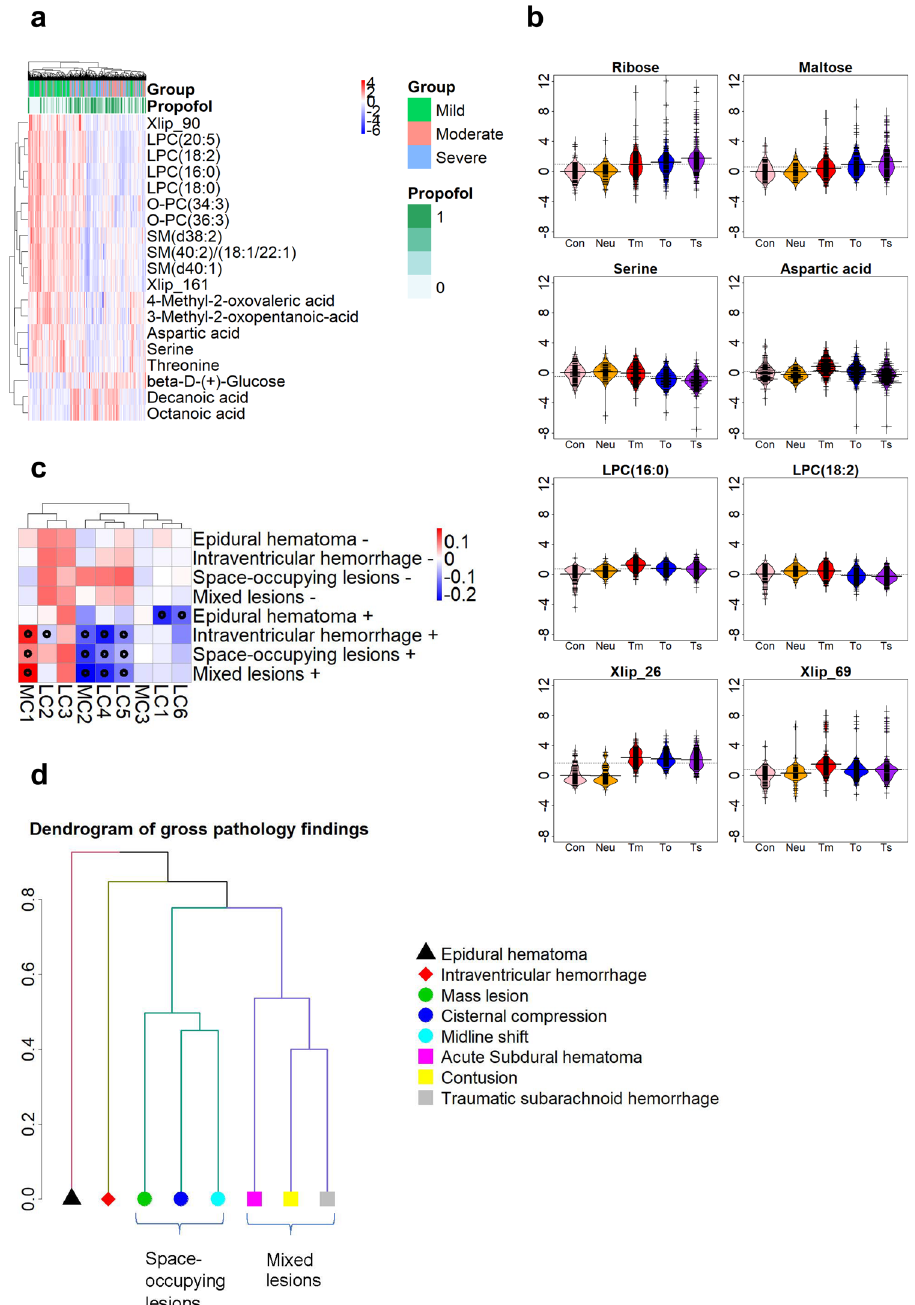
Fig. 3 Survey of metabolome in TBI severity and gross pathologies. a Heatmap of the 19 most important features for discrimination of TBI severity, showing also study group and propofol administration. These features were selected from the overall of the top 30 metabolites from a random forest model and the top 30 metabolites as selected by the Welch F test. b Levels of selected top-ranking metabolites across six study groups. The data were standardized based on the levels of internal medicine and orthopedic patients, denoted as controls. Group abbreviations: Con (control; internal and orthopedic), Neuro (neurological patients, mostly acute stroke), Tm (mild TBI), To (moderate TBI), Ts (severe TBI). c Heatmap of the gross pathologies fi ndings and the 11 metabolite clusters. Boxes with stars denote signi fi cant differences between positive and negative fi ndings. d Dendrogram of the clustering results for the gross pathology types from CT. A hierarchical clustering method was applied where a similarity measure between the common combinations was used as the metric for the clustering. The y-axis in the plot denotes the dissimilarity measure based on the Jaccard distance of the difference pathologies, with distance close to 0 being the most similar. Based on these, mass lesion, cisternal compression, and midline shift were grouped in the space-occupying cluster, and acute subdural hematoma, contusion, and traumatic subarachnoid hemorrhage were grouped as the mixed lesions cluster. These clusters are seen in panel c .